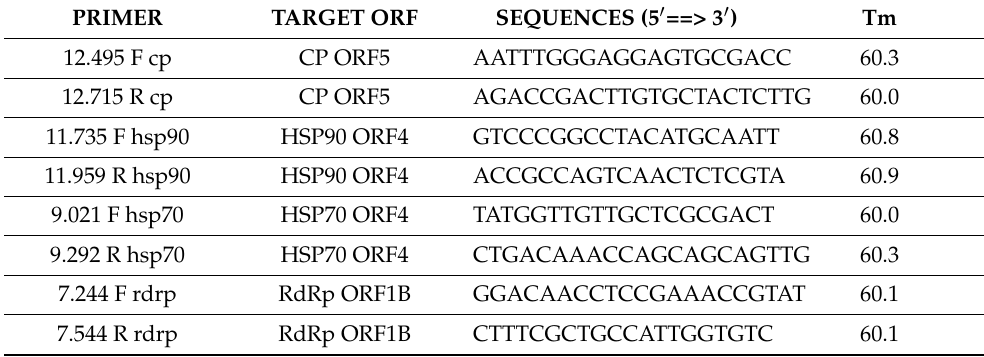
Table 2. RT-PCR primer pairs used for the confirmation of the viral sequences in the samples.